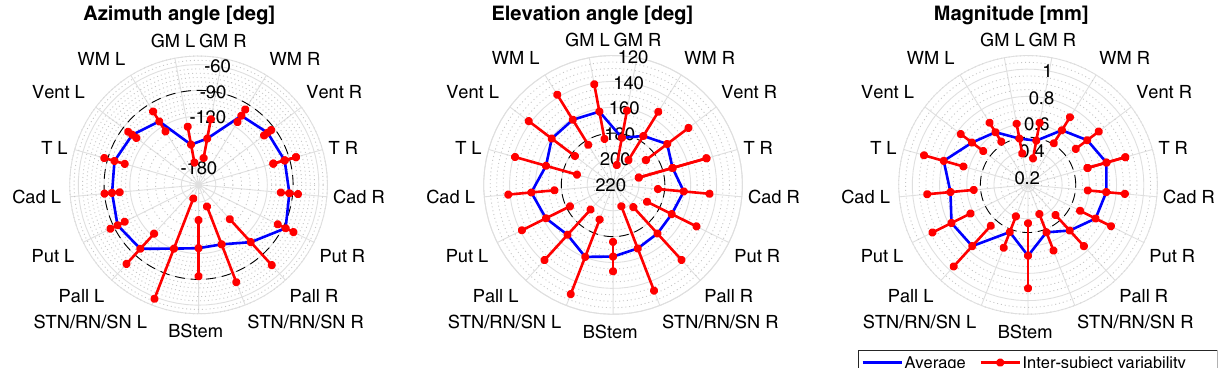
Figure 3. Polar diagrams showing azimuth (left) and elevation (centre) angles as well as magnitude (right) of PBS averaged over some ROI: left (L) and right (R) gray matter (GM), white matter (WM), ventricles (Vent), thalamus (T), caudate (Cad), putamen (Put), pallidus (Pall), subthalamic nucleus (STN), red nucleus (RN), substantia nigra (SN) and brain-stem (BStem). Whiskers represent inter-subject variability. Decreasing values of azimuth angle in the [− 90, − 180 ] ◦ range represent vectors progressively oriented towards left, whereas increasing values of elevation angle in the [ 90, 270 ] ◦ range represent vectors progressively oriented downwards. STN, RN and SN were combined together due to the small number of voxels represented by these structures.